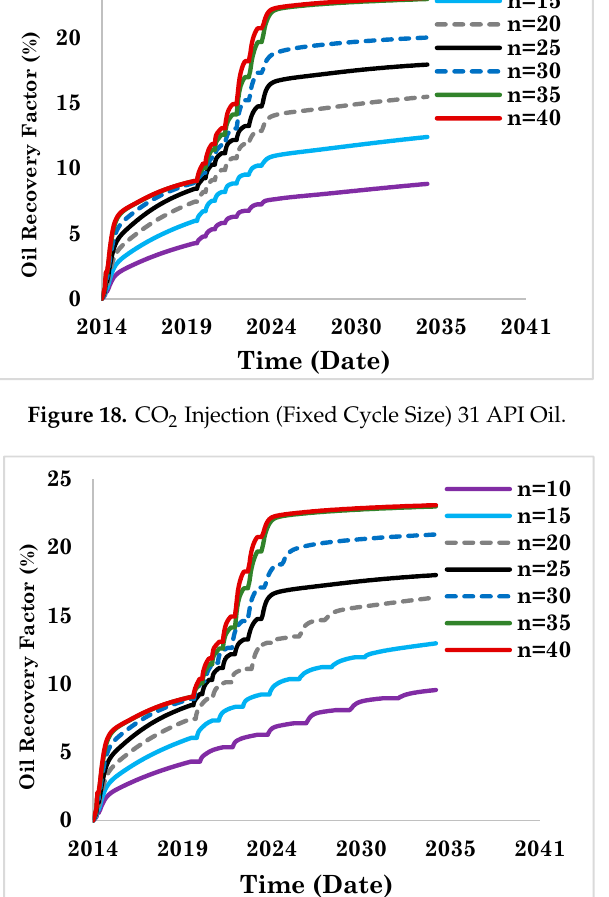
Figure 19. CO 2 Injection (Extended Cycle Size) 31 API Oil.